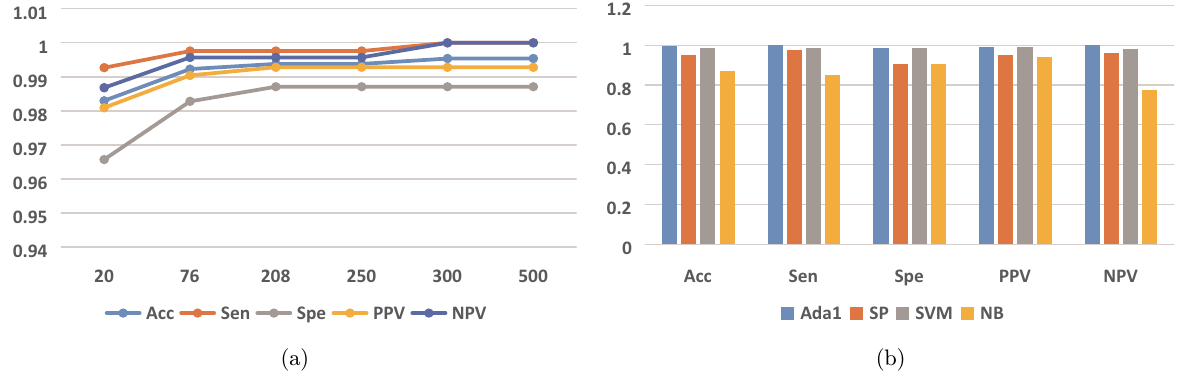
Fig. 6. Classi¯cation performance validation. (a) Performance comparison in terms of di®erent tree numbers and (b) performance comparison of four